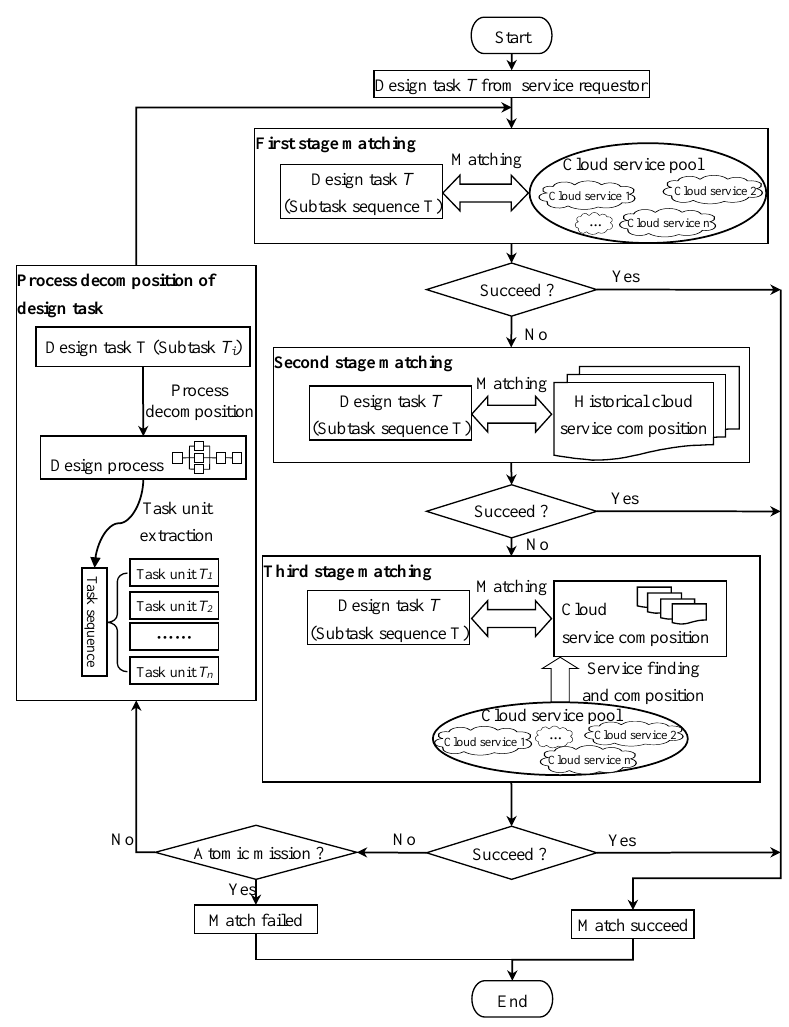
Figure 3. Multistage service matching based on task hierarchical